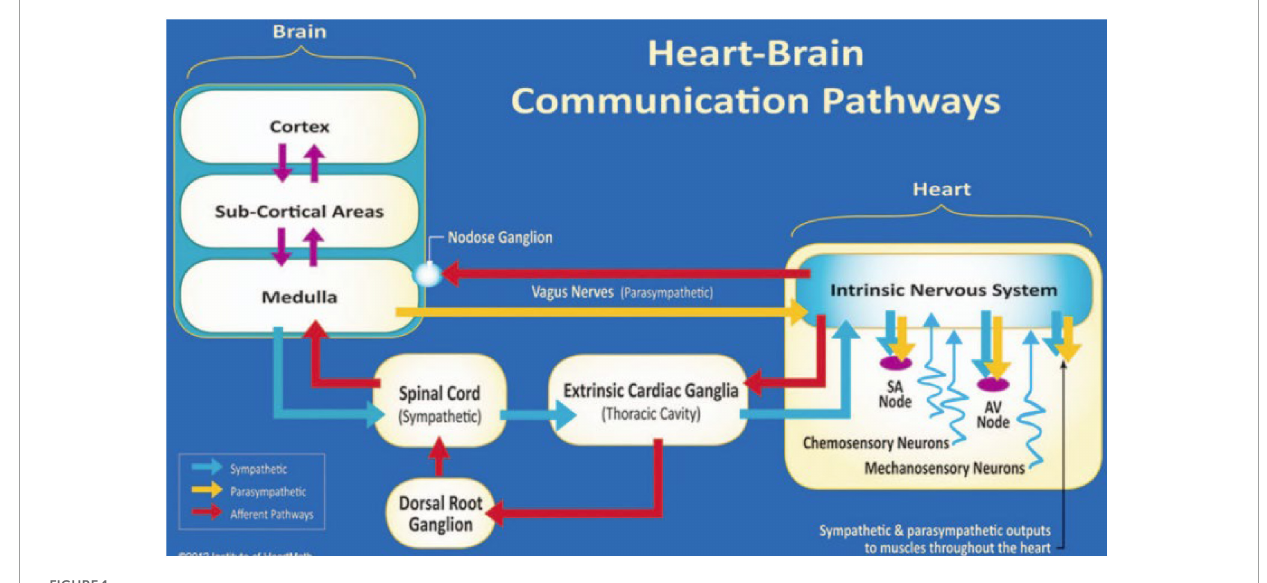
FIGURE1 The neural communication pathways interacting between the heart and brain are responsible for the generation of HRV. The intrinsic cardiac nervous system integrates information from the extrinsic nervous system and the sensory neurites within the heart. The extrinsic cardiac ganglia located in the thoracic cavity have connections to the lungs and esophagus and are indirectly connected via the spinal cord to many other organs, including the skin and arteries. The vagal nerve (parasympathetic) primarily consists of afferent (flowing to the brain) fibers that connect to the medulla. Used with permission from the Institute of HeartMath, Boulder Creek, California (McCraty and Shaffer,